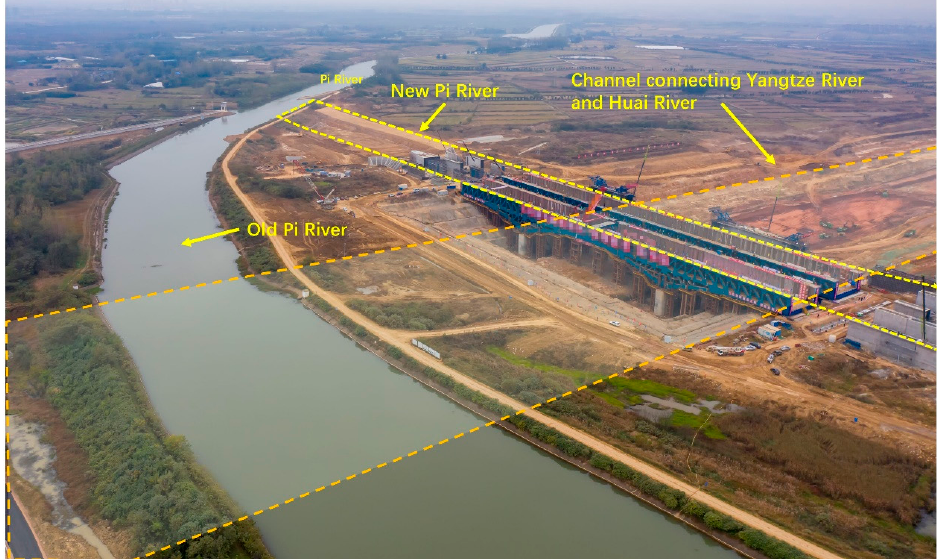
Figure 1. Location of the steel truss aqueduct.